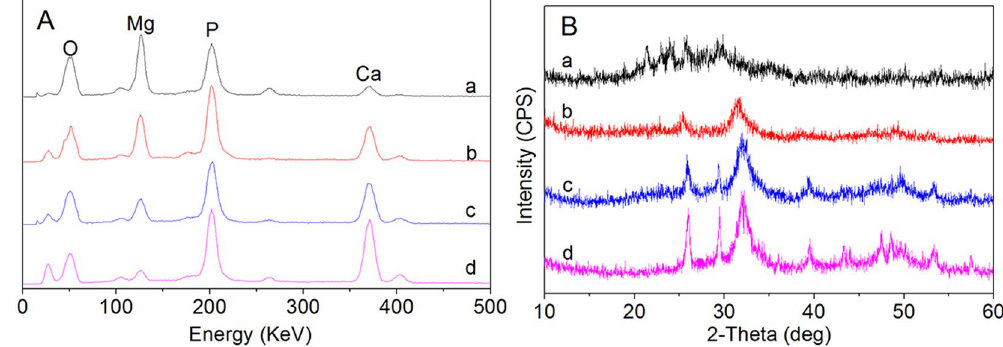
Figure 5. EDS and XRD results for MP0 ( a ), MP4 ( b ), MP6 ( c ) and MP8 ( d ) after soaking in SBF for 7